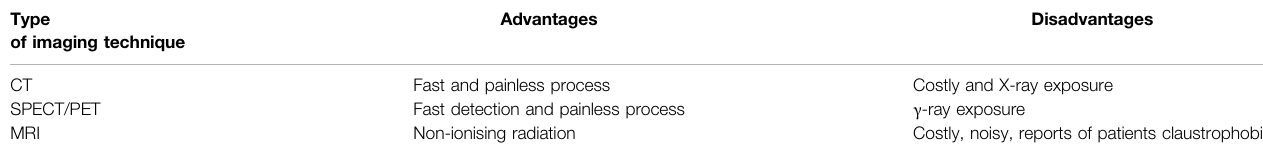
TABLE 1 | Advantages and disadvantages of imaging techniques.